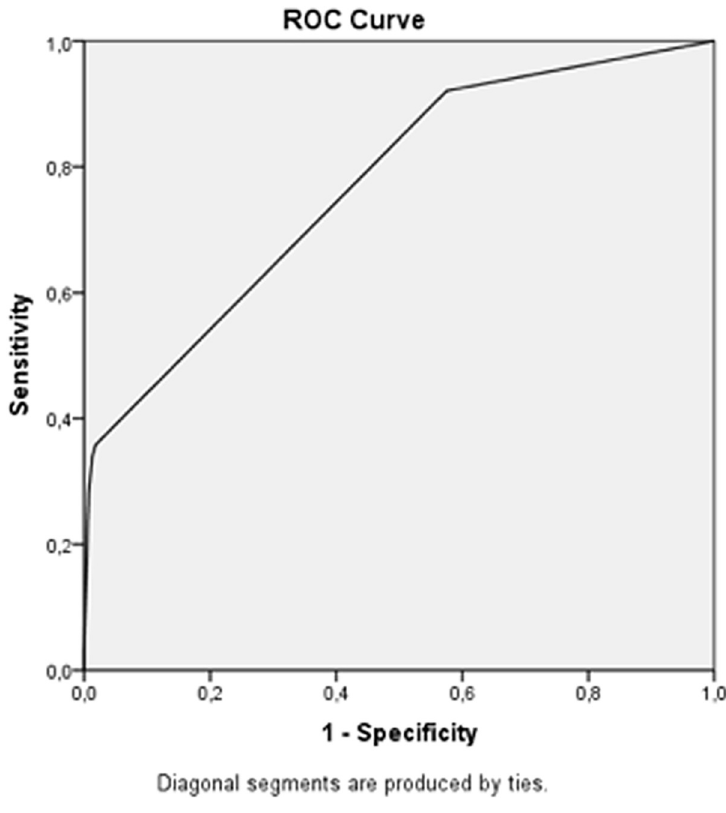
Fig 1. ROC Curve AUC 0.77